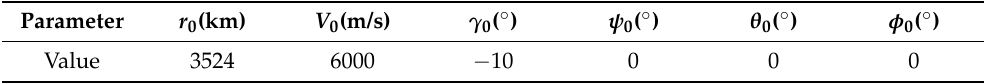
Table 2. Initial state